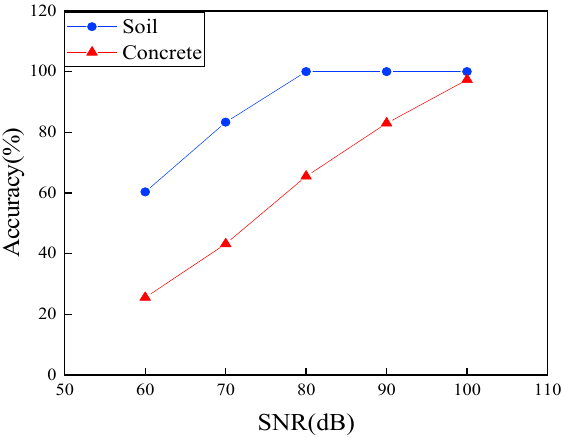
Figure 31. Accuracy of the models for embedding cases with respect to different noise levels.